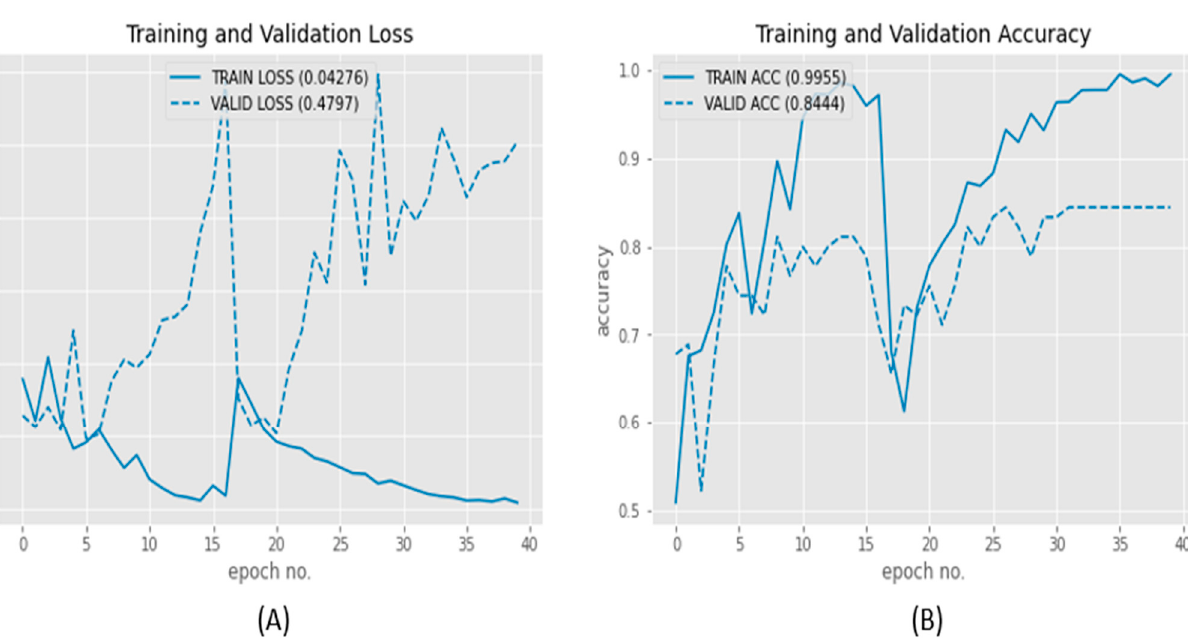
Figure 10. Original data performance ( A ) loss ( B ) accuracy